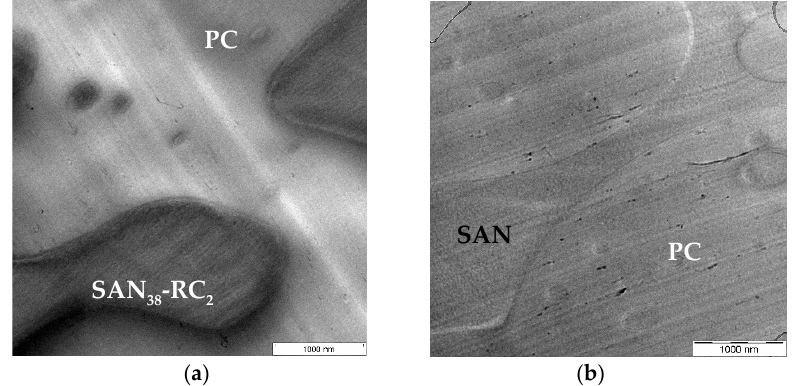
Figure 4. TEM images of HiPCo TM SWCNT filled PC 60 /SAN 40-x -RC x blends: ( a ) PC 60 /SAN 38 -RC 2 blends showing HiPCo TM SWCNTs (0.5 wt. %) localized in PC and ( b ) in PC 60 /SAN 40 blends HiPCo TM SWCNTs (0.5 wt. %) stay in PC.